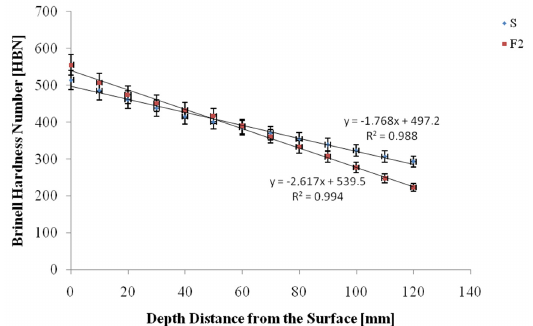
Figure 3. Hardness Value vs Depth for S and F2.